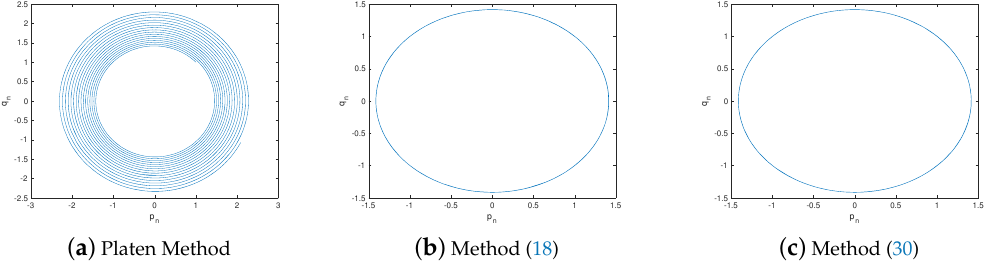
Figure 3. Numerical sample paths of the Platen method, method (18), and method (30).